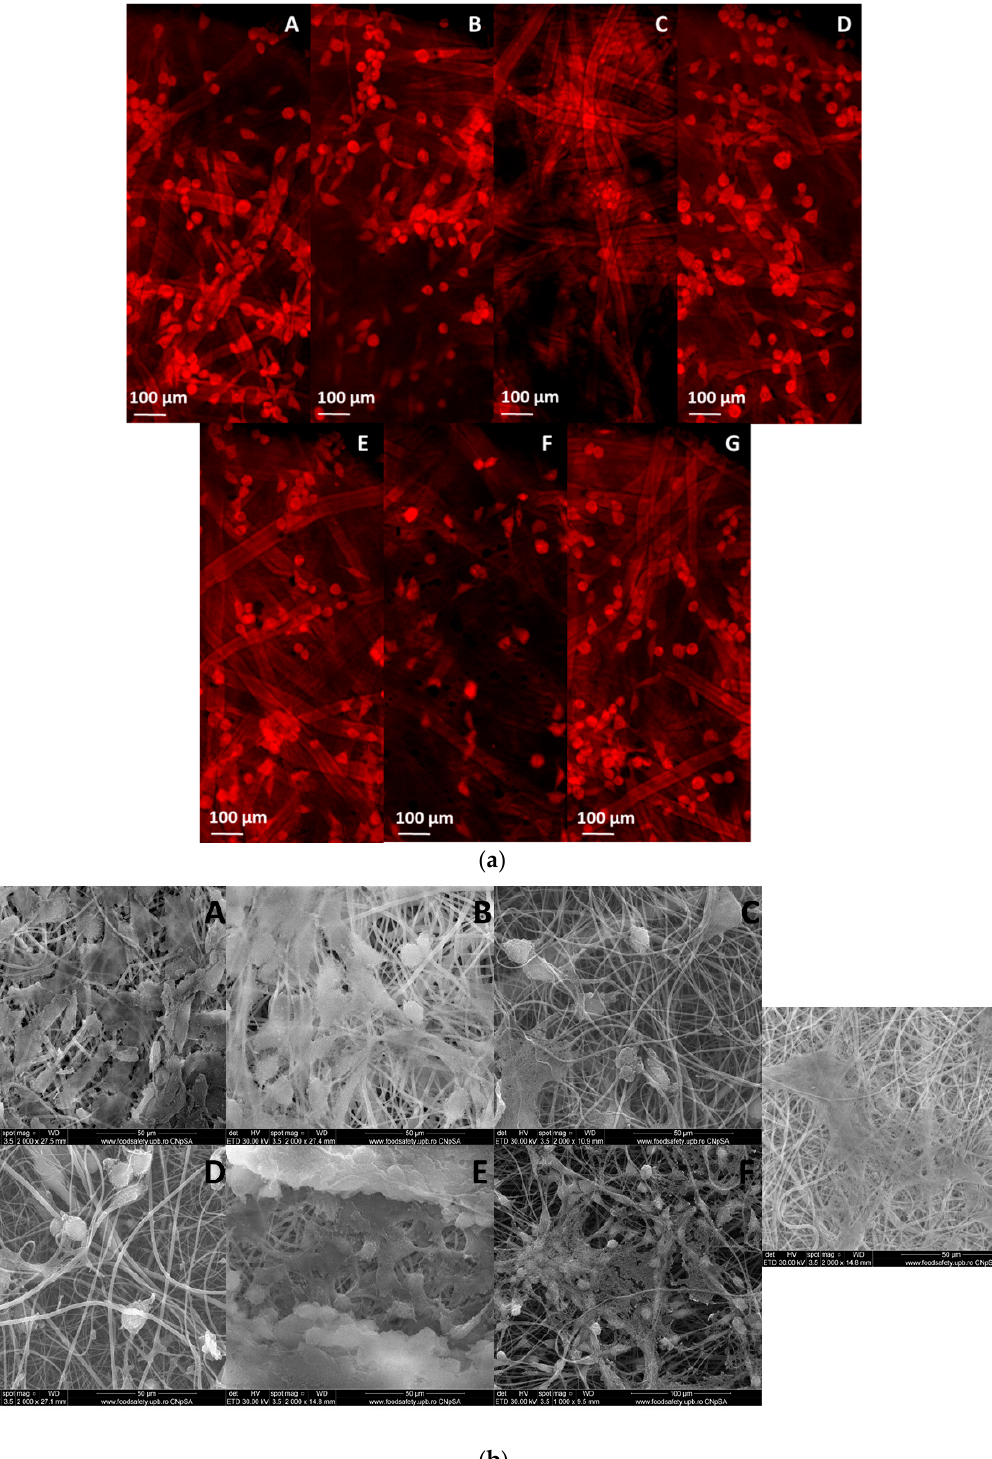
Figure 10. Fluorescence microscopy images ( a ) of L929 fibroblast cells at 24 h after direct interaction with samples and SEM images ( b ) of the fibroblast cells on the microfiber scaffolds: ( A ) 10%PLA (scale bar 50 μ m, 2000× magnification), ( B ) 10%PLA/0.1%GO (scale bar 50 μ m, 2000× magnification), ( C ) 10%PLA/0.5%GO (scale bar 50 μ m, 2000× magnification), ( D ) 10%PLA/1%GO (scale bar 50 μ m, 2000× magnification), ( E ) 10%PLA/0.1%GO/Q (scale bar 50 μ m, 2000× magnification), ( F ) 10%PLA/0.5%GO/Q (scale bar 100 μ m, 1000× magnification), ( G ) 10%PLA/1%GO/Q (scale bar 50 μ m,